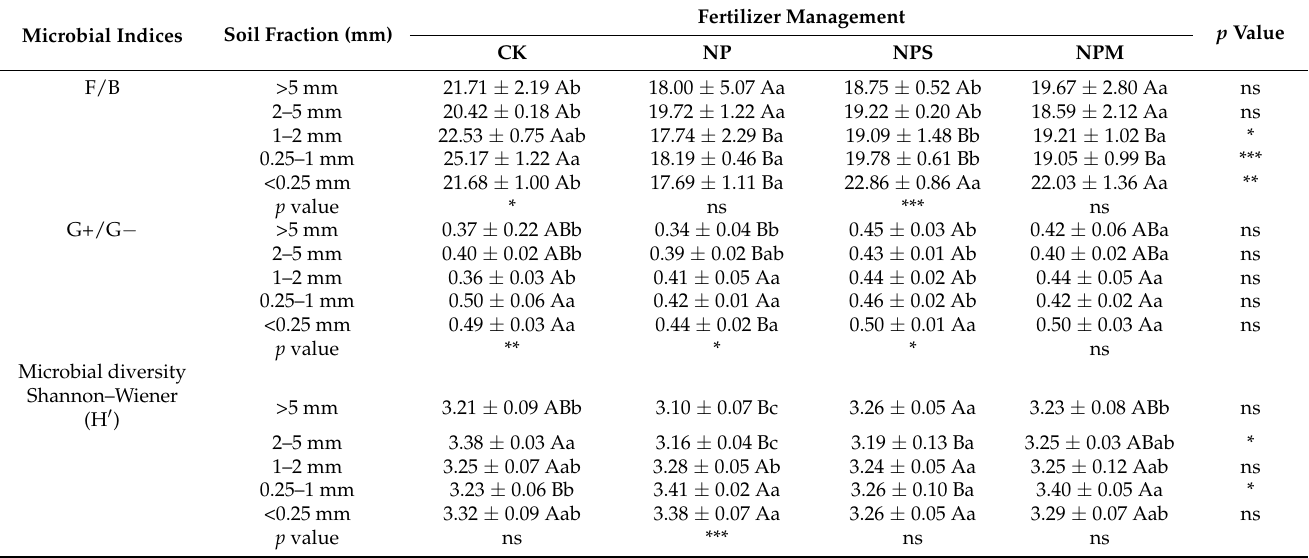
Figure 4. Microbial biomass and the phospholipid acid biomarkers in differently sized aggregates under 4 fertilization managements: CK ( A ), NPS ( B ), NP ( C ), and NPM ( D ). G − B: general bacterial PLFA; G+: Gram-positive bacterial PLFA; G − : Gram − negative bacterial PLFA; A: actinomycetic PLFA; F: general fungal PLFA; AM: arbuscular mycorrhizal fungi. The differences in total bacteria (the sum of G − B, G+, and G − bacteria), actinomycetes, general fungi, and AM PLFA among the differently sized aggregates are shown at *: p < 0.05, **: p < 0.01, ***: p < 0.001, and ns: not significant. Table 3. Microbial PLFA biomass and ratios of the phospholipid acid biomarkers and microbial diversity in differently sized aggregates.